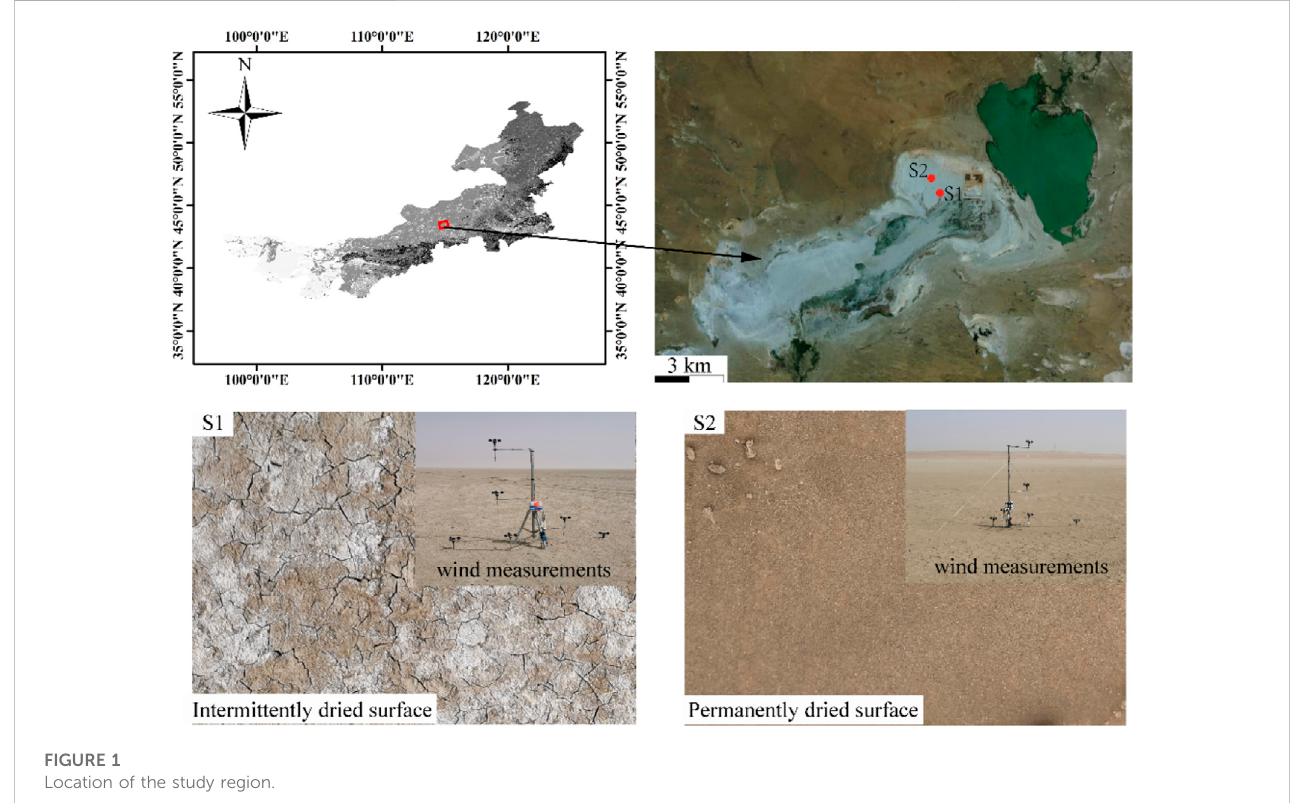
FIGURE 1 Location of the study